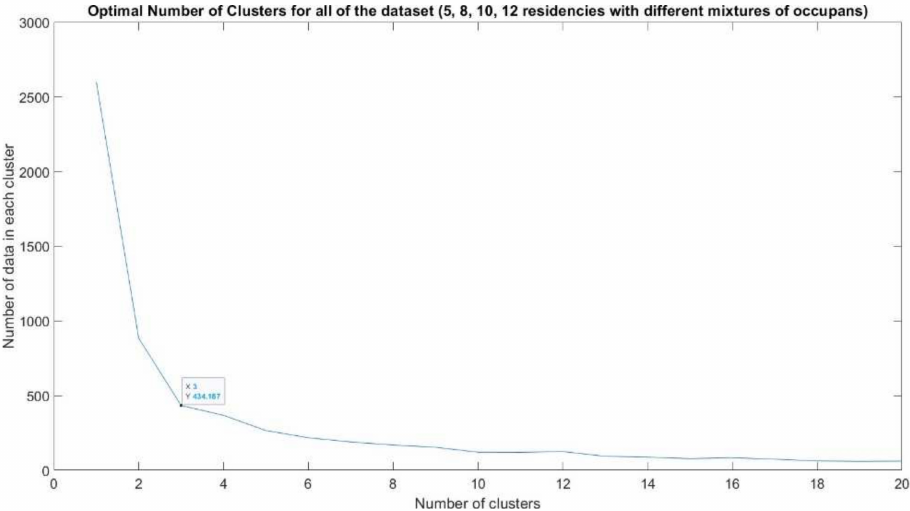
Figure 2. Optimal number of clusters for the data of Table 2 for the case of students’ residences in Kimmeria, Xanthi.